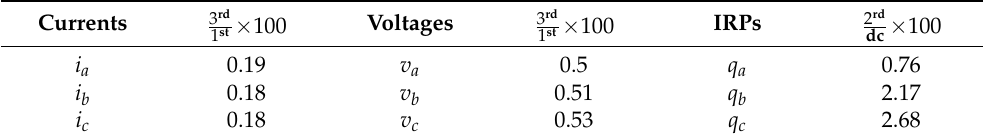
Table 2. Percentages of Fault Feature